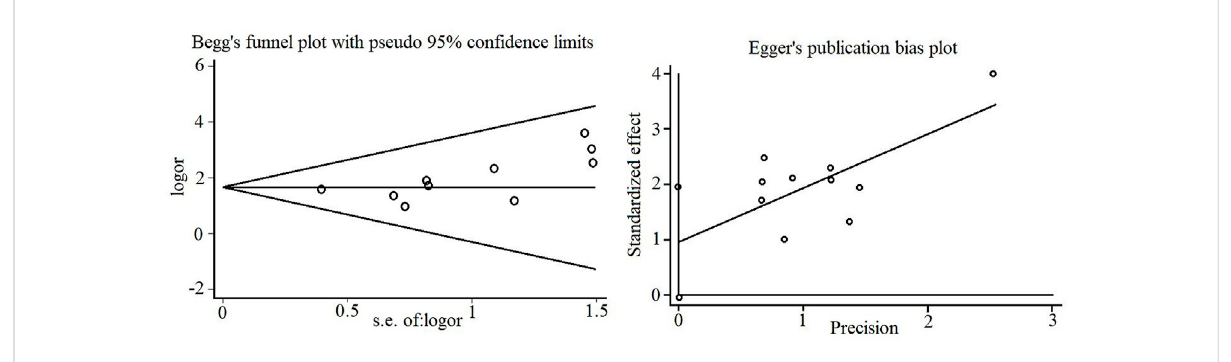
FIGURE 9 Begg ’ s and Egger ’ s funnel plots for publication bias.